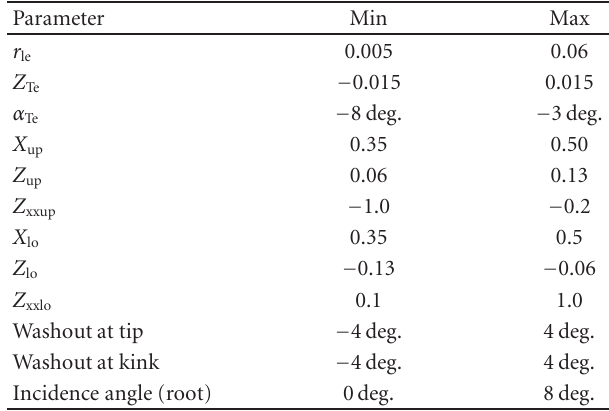
Table 2: Range of design parameters for PARSEC airfoil and twist